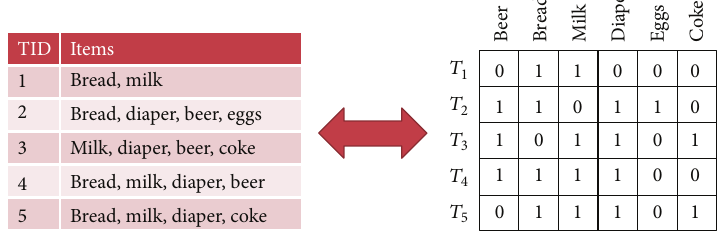
Figure 2: Bit-table representation of market basket data.